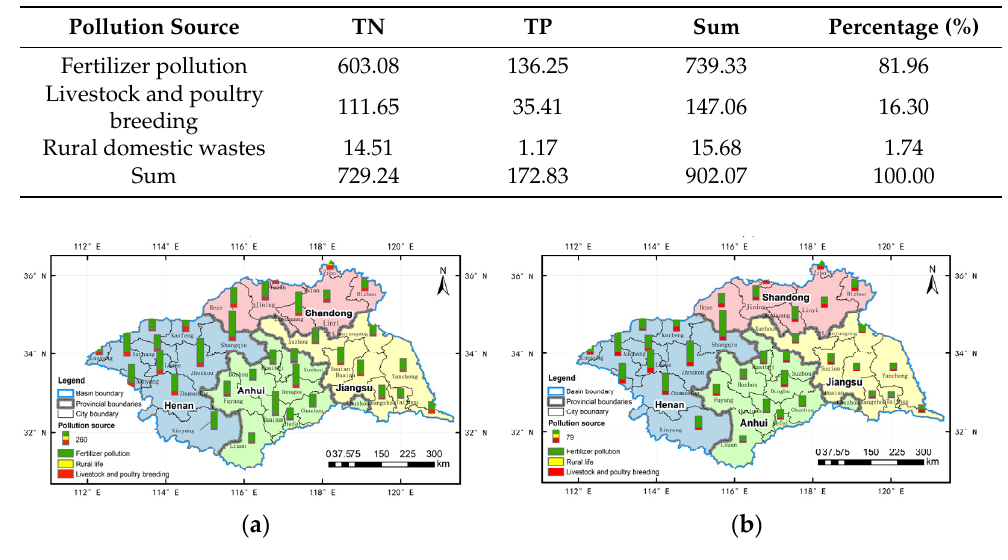
Figure 3. ( a ) The distribution of TN in HRB; ( b ) the distribution of TP in HRB.